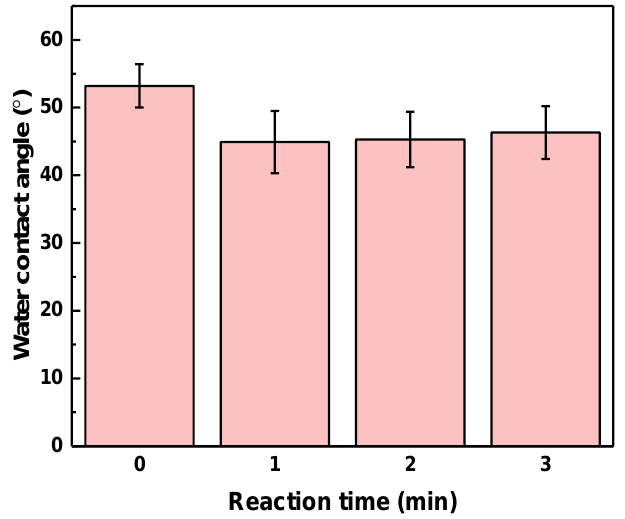
Figure 3. Water contact angle of the membranes, coated at different reaction times, of TA and FeIII.